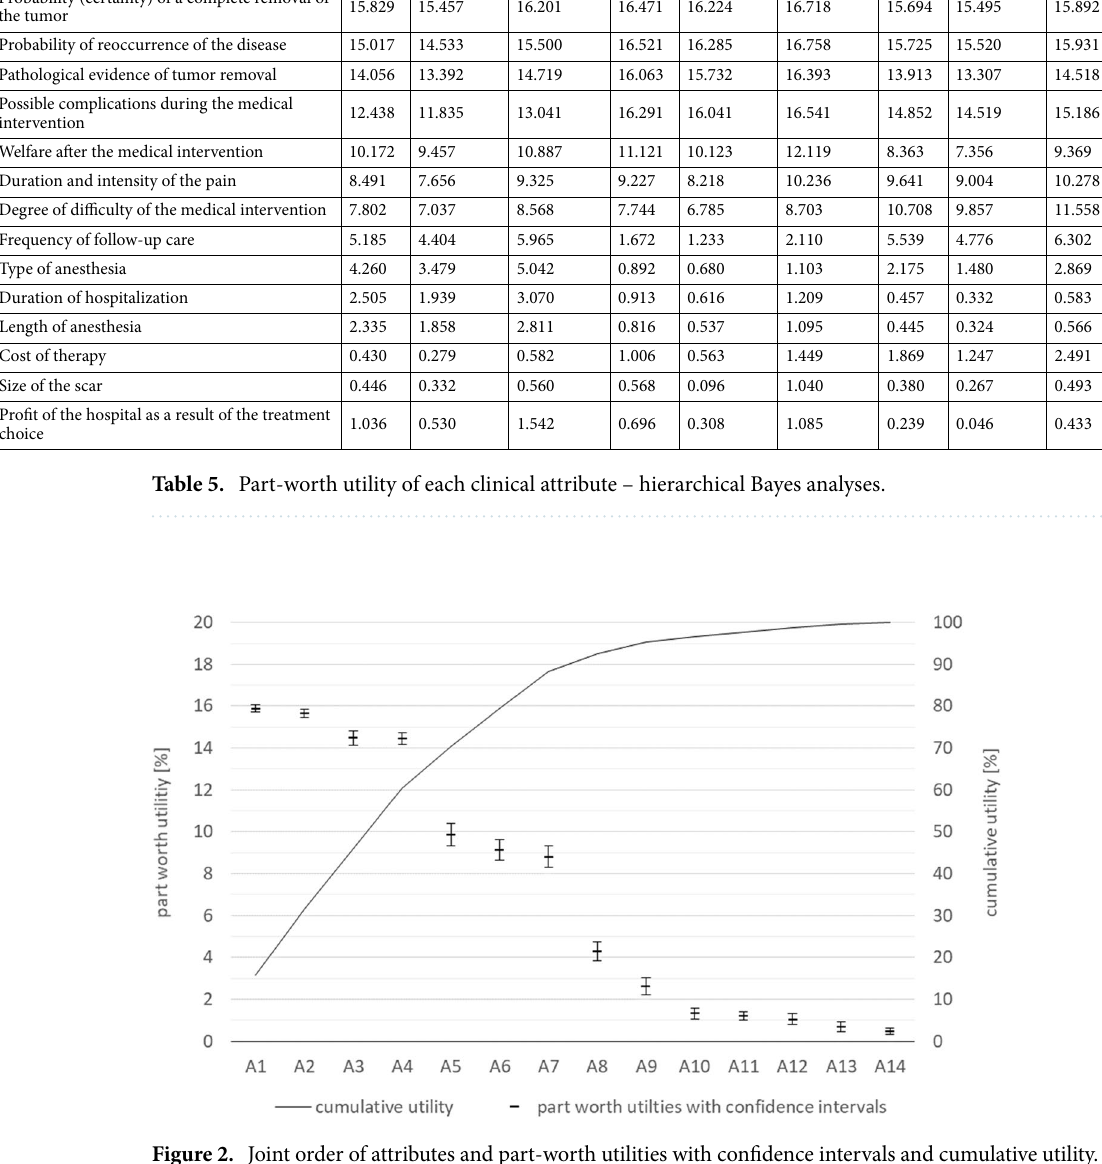
Figure 2. Joint order of attributes and part-worth utilities with confidence intervals and cumulative